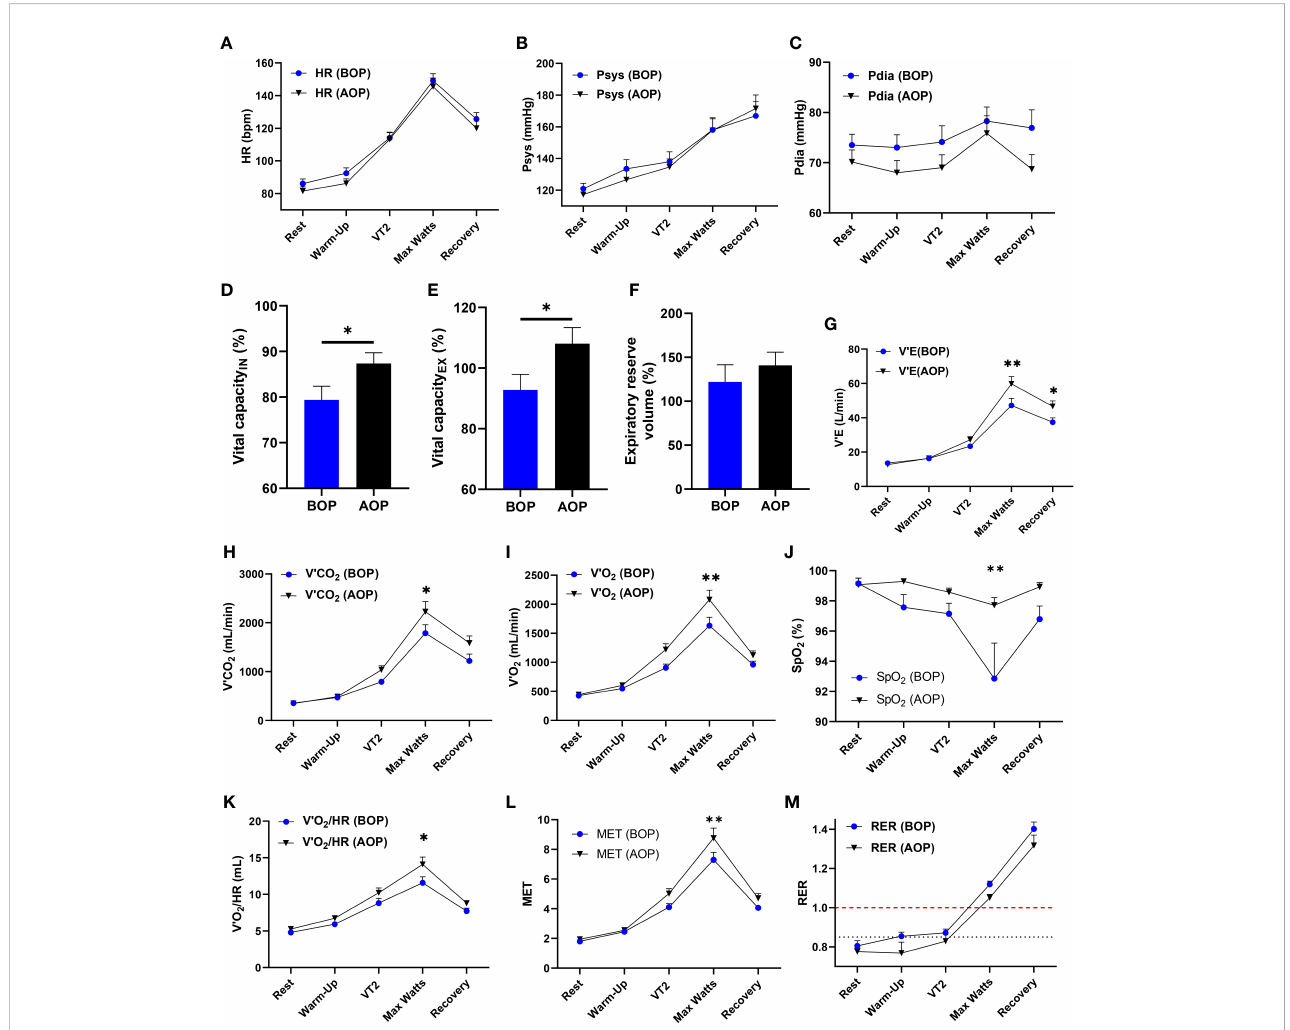
FIGURE 6 OP enhances respiratory and oxygen-carrying capacity in humans. (A-M) Cardiopulmonary Exercise Test (CPET) indexes for respiratory and oxygen carrying capacity in humans (n=14 human volunteers), Before occlusion preconditioning (BOP) and After occlusion preconditioning (AOP), including; Graphical plots of Heart Rates (HR), Systolic blood pressures (Psys), Diastolic blood pressures (Pdia), Vital capacity of inhalation (IN), Vital capacity of exhalation(EX), Expiratory reserve volume, Minute ventilation (V ’ E), Carbon dioxide output (V ’ CO 2 ), Oxygen uptake (V ’ O 2 ), Oxygen saturation (SpO 2 ), Oxygen pulse (V ’ O 2 /HR), Metabolic equivalent of task (MET) and Respiratory exchange ratio (RER). Rest, Warm-up, Second ventilation threshold (VT2), Maximal workload (Max Watts) and Recovery are timepoints of interest during the CPET. *p<0.05, **p<0.01 AOP vs BOP. Data are expressed as mean ± SEM. Data were analyzed using an unpaired t-test for comparing two groups and two-way ANOVA for grouped